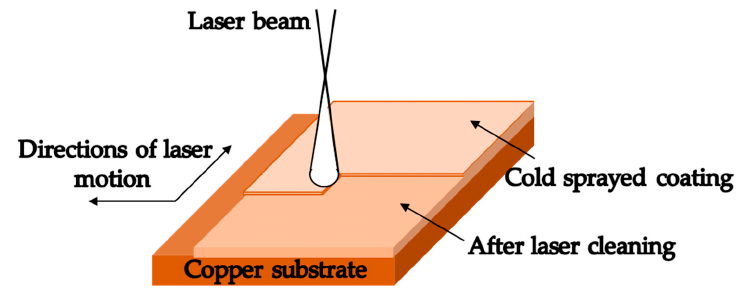
Figure 2. Full coverage pattern scanning.